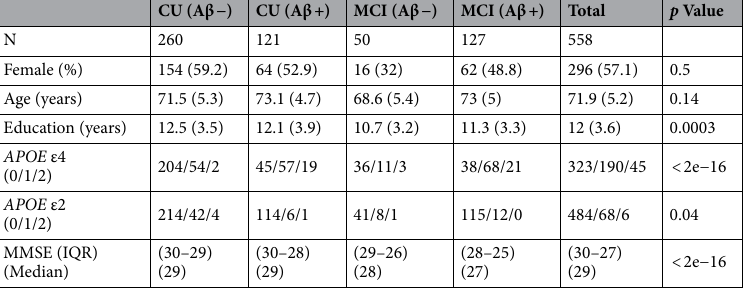
Table 1. Demographics and baseline characteristics. Age and education data are mean (standard deviation). CU cognitively unimpaired, MCI mild cognitive impaired. The group mean difference was calculated based on ANOVA.